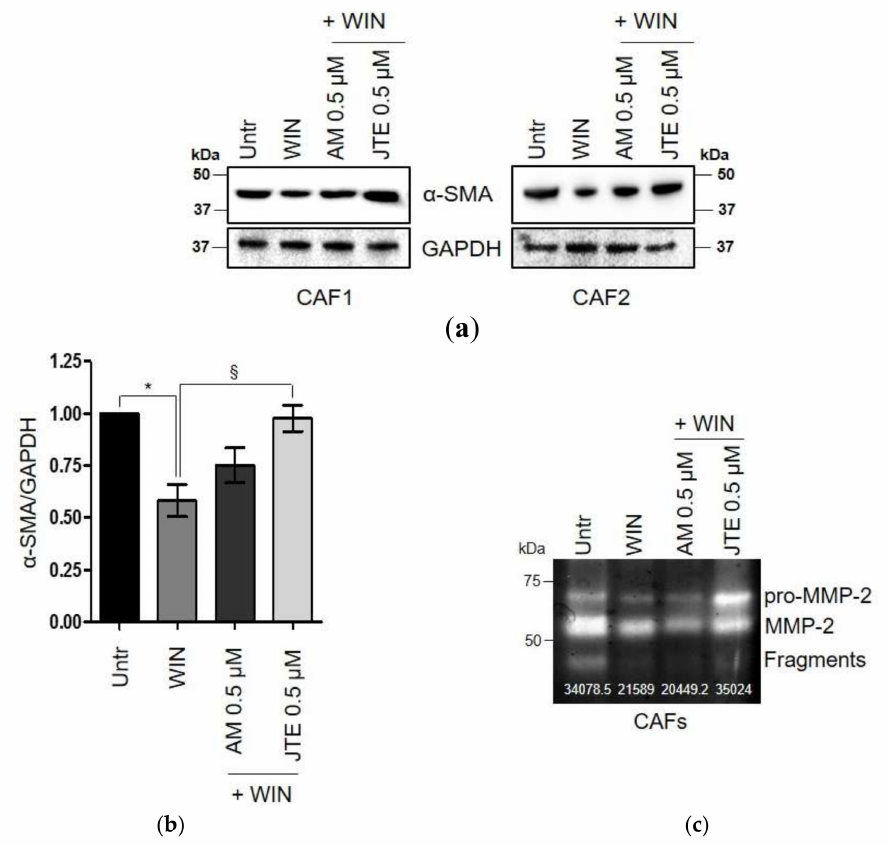
Figure 4. The effect of WIN 55-212.2 mesylate on CAFs phenotype is mainly mediated by CB 2 . ( a ) Representative immunoblot of α -SMA expression in CAFs isolated from two different explants (CAF1 / CAF2) treated with WIN 55-212.2 mesylate 2.5 µ M for 24 h in presence or not of AM281 and JTE-907 0.5 µ M. Cells were pre-treated for 3 h with the antagonists, then WIN 55-212.2 mesylate was added. ( b ) Quantitative results of western blot analysis. Relative expressions were normalized with respect to GAPDH and shown as FC respect to control cells maintained in serum-deprived medium (Untr). Data represent means ± SEMs of three independent biological replicates performed on two different patient-derived CAFs. One-way ANOVA, Bonferroni’ corrected. * p < 0.05 versus Untr; § p < 0.05 versus WIN. ( c ) Gelatin zymography of conditioned media (10 fold concentrated) from CAFs treated as above. The white numbers in bolt indicate quantification of two independent biological